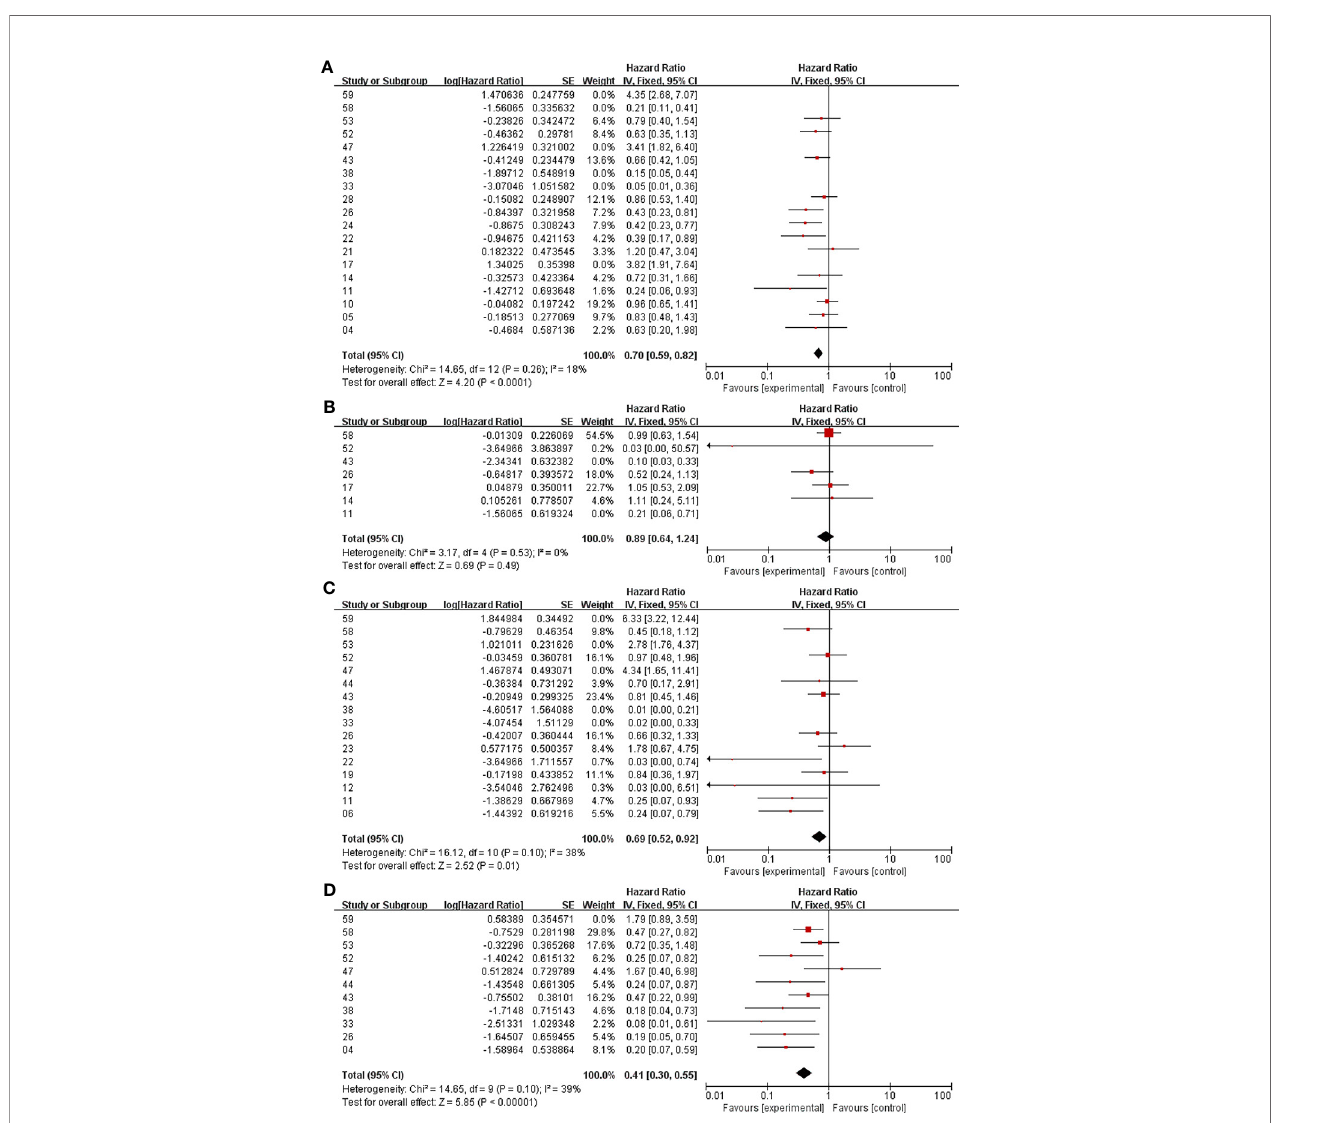
FIGURE 4 | Meta-analysis after sensitivity analysis. Surgery+RT vs Surgery, PFS (A) . Surgery+RT vs Surgery, OS (B) . GTR+RT vs GTR, PFS (C) . STR+RT vs STR, PFS (D)